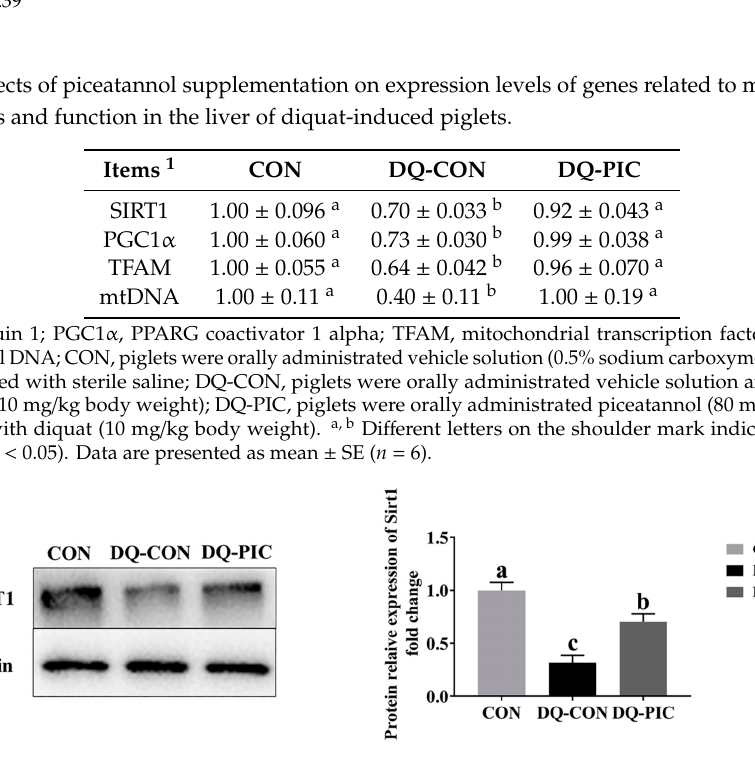
Figure 5. Effects of piceatannol supplementation on expression levels of SIRT1 protein in the liver of diquat-induced piglets. The column and its bar represented the means value and SE ( n = 6), respectively. SIRT1, sirtuin 1; CON, piglets were orally administrated vehicle solution (0.5% sodium carboxymethyl cellulose) and challenged with sterile saline; DQ-CON, piglets were orally administrated vehicle solution and challenged with diquat (10 mg/kg body weight); DQ-PIC , piglets were orally administrated piceatannol (80 mg/kg/day) and challenged with diquat (10 mg/kg body weight). a, b, c Different letters on the shoulder mark indicate significant differences ( p < 0.05).